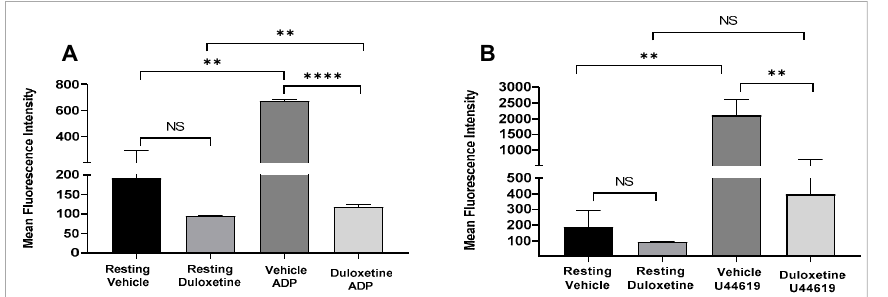
Figure 2. Duloxetine inhibits platelet α -granule secretion. Human platelets were pre-incubated with duloxetine (35 µ M) or the vehicle for one minute. Platelets were stimulated with ADP (1 µ M; ( A )) or U46619 (5 µ M; ( B )) and incubated with FITC–conjugated P-selectin antibody. Fluorescent inten- sities were measured by flow cytometry. Average mean fluorescence intensities shown (** p < 0.01; **** p < 0.0001; NS, nonsignificant). These experiments were repeated three times, using blood ob- tained from three different healthy human subjects. The results were compared by running a one-way ANOVA followed by Tukey’s multiple comparisons test using GraphPad Prism.